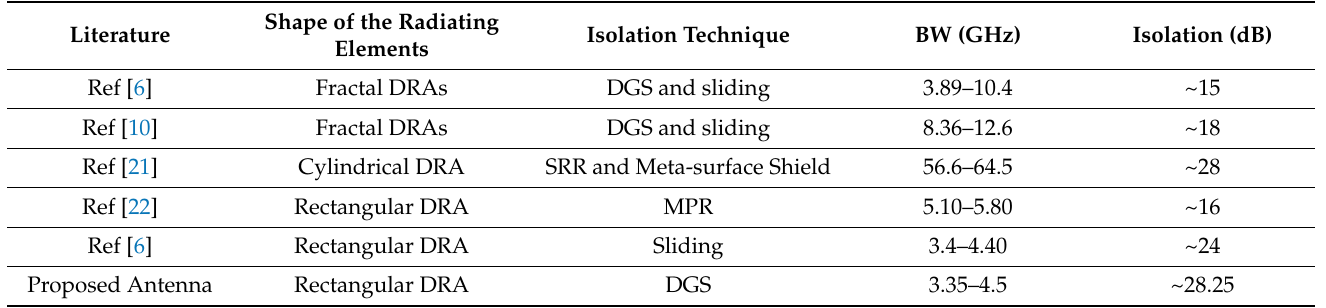
Table 6. Table 5. Comparisons with other MIMO